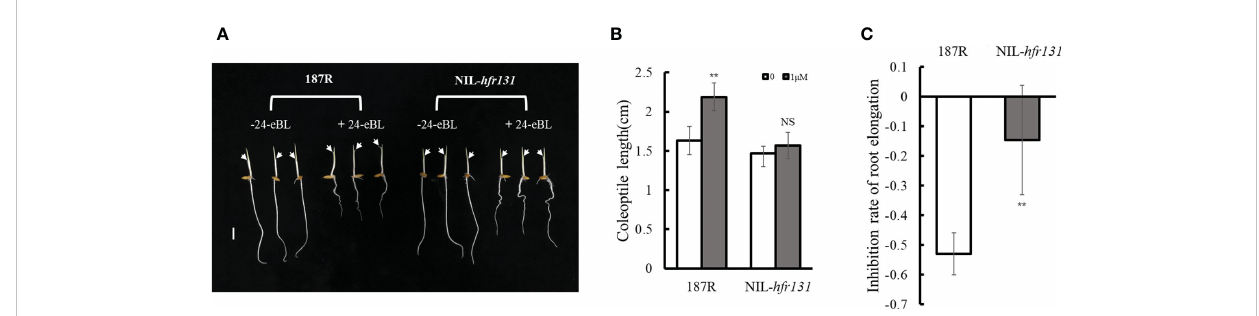
FIGURE 2 Responses of rice ‘ 187R ’ and NIL- hfr131 to 24-epibrassinolide (24-eBL). (A) Effect of 24-eBL on coleoptile and root elongation in seedlings. The arrows indicate the top of the coleoptile. Bar = 1 cm. (B) Coleoptile length of 187R and NIL- hfr131 seedlings in the presence or absence of 1 m M/L 24-eBL. (C) Inhibition of root elongation of 187R and NIL- hfr131 in response to 1 m M/L 24-eBL. ** P < 0.01, NS non-signi fi